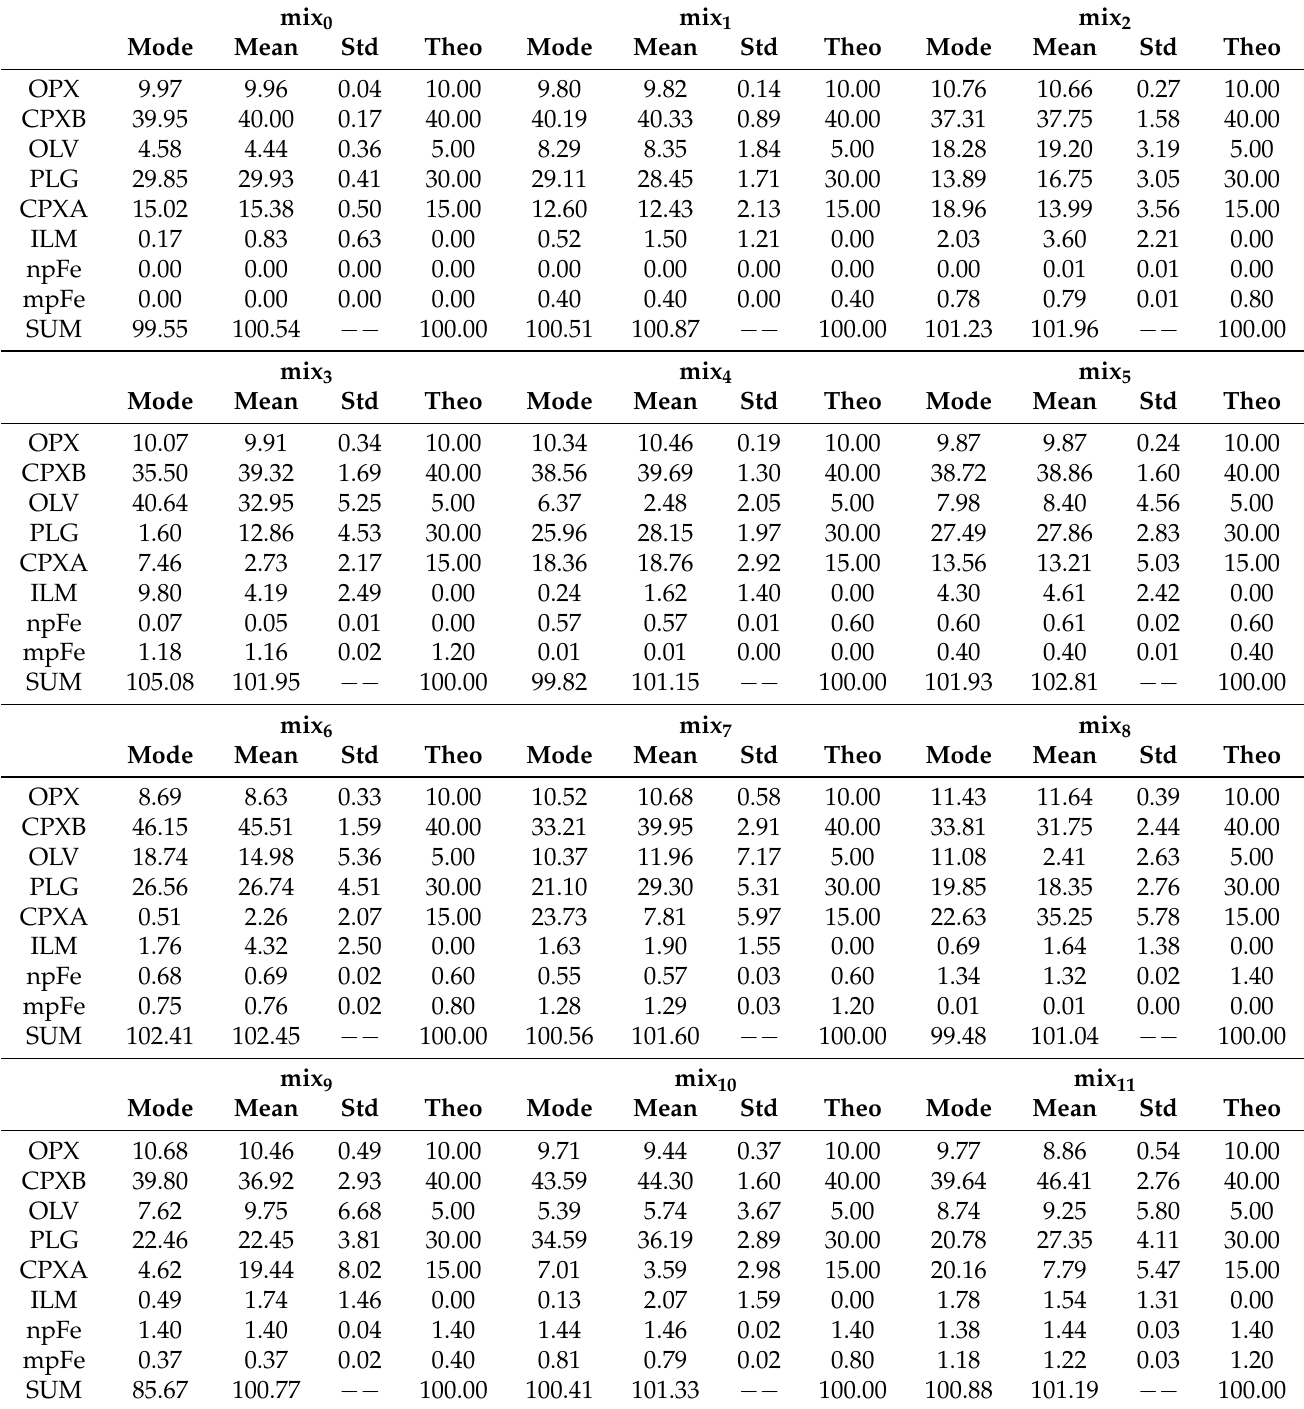
Table A3. Detailed results for the unmixing of the synthetically generated by using the forward mixing model. Only a uniform prior on the elemental and mineral abundances was